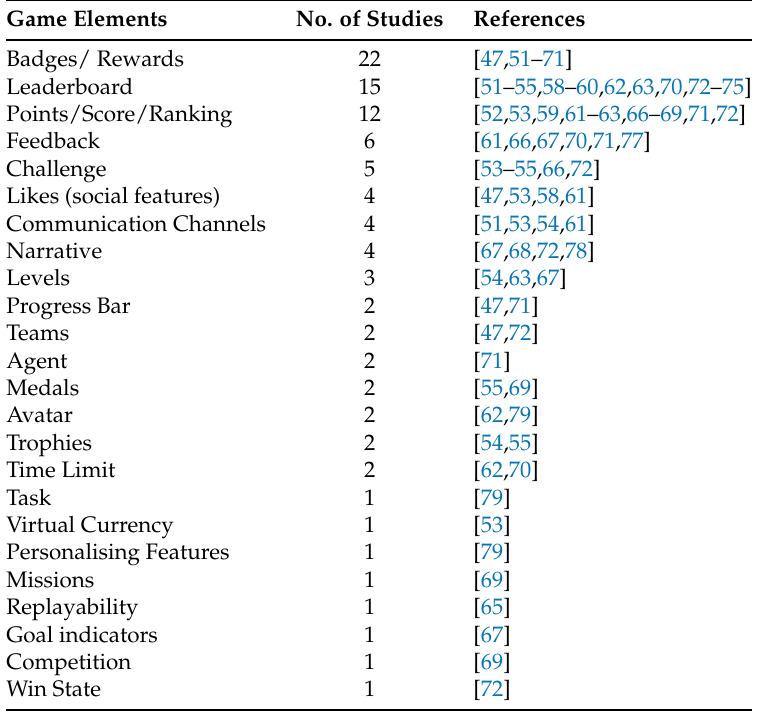
Table A2. Map of the game elements most used in online learning environments.